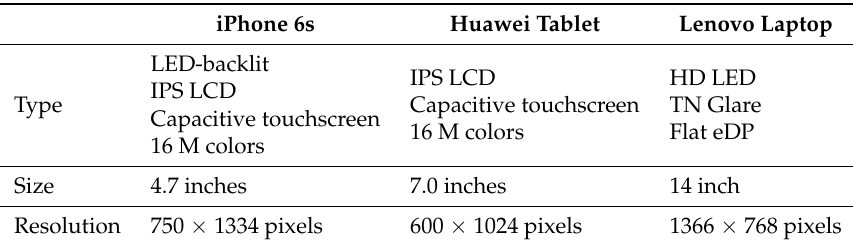
Table 4. Device screen